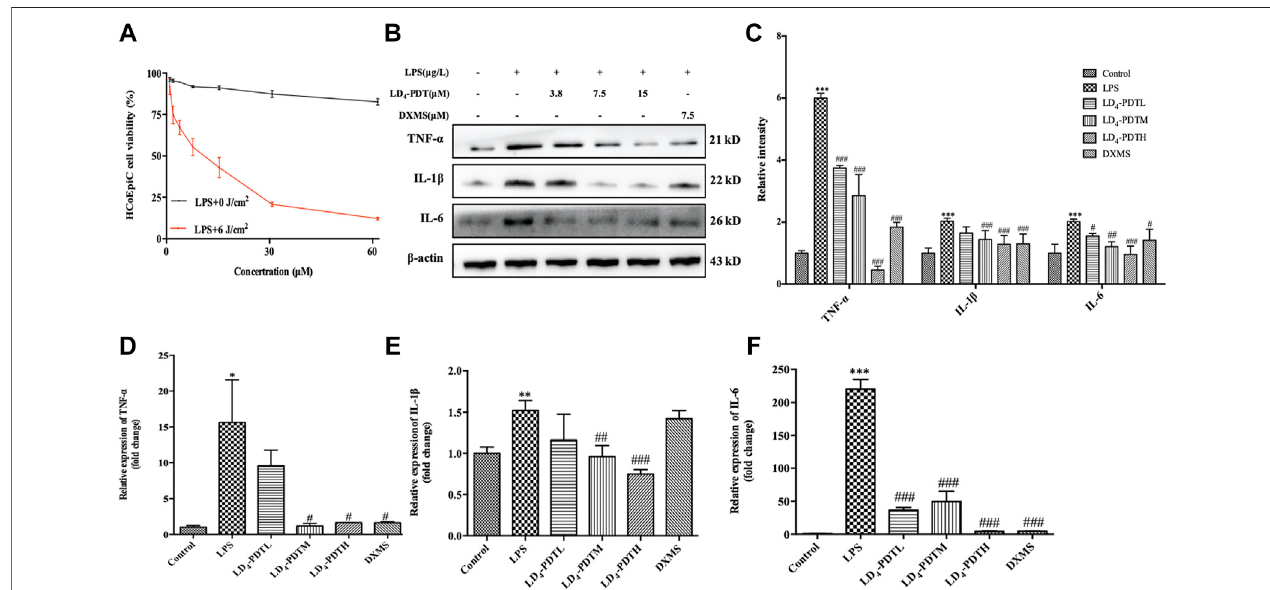
FIGURE 1 | LD 4 -PDT reduced in fl ammation in LPS-induced HCoEpiC cells. (A) HCoEpiC cells were incubated with LPS for 24 h, LD 4 (0 – 60 μ M) for 30 min, then irradiated (6 J/cm 2 ) or untreated. Cell viability was detected by MTT assay. Red line indicated the light reaction; black line indicated the dark reaction. (B,C) Protein expression of TNF- α , IL-6 and IL-1 was determined by western blot. (D – F) Expression levels of TNF- α , IL-6 and IL-1 in HCoEpiC cells were examined by qRT-PCR. ** p < 0.01 , *** p < 0.001 vs control group; # p < 0.05 , ## p < 0.01 , ### p < 0.001 vs LPS model group. Data are representative of three independent experiments, expressed as mean ±